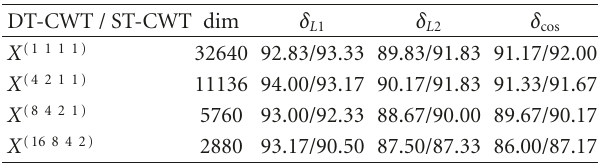
Table 4: Face recognition performance for DT-CWT and ST-CWT with di ff erent downsampling factors using FERET database and three di ff erent similarity measures: L 1 distance measure, δ L 1 , L 2 distance measure, δ L 2 and cosine similarity measure, δ cos